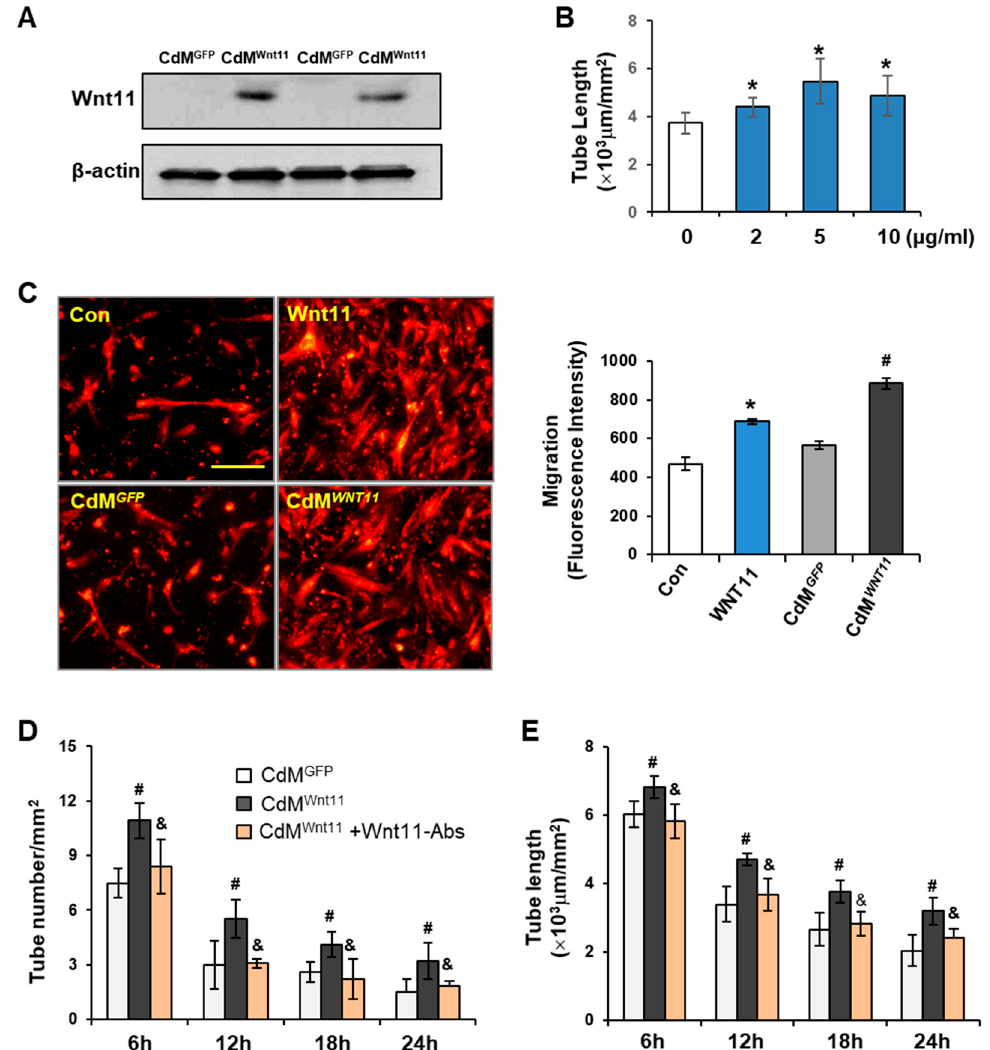
Figure 4. Wnt11 promotes CdM Wnt11 -mediated capillary-like tube (CLT) formation and HUVEC migration. ( A ): Representative images of Western blot on expression of Wnt11 in CdM Wnt11 and CdM GFP . ( B ): The effect of Wnt11 on HUVEC-mediated CLT formation. ( C ): Representative images of HUVEC migration and quantitative data of fluorescence intensity. The scale bars represent 100 µ m. ( D , E ): Wnt11 neutralized antibody partially abolished CdM Wnt11 -mediated CLT formation. *, p < 0.05 vs. Control, # p < 0.05 vs. CdM GFP ; & , p < 0.05 vs. CdM Wnt11 , respectively.